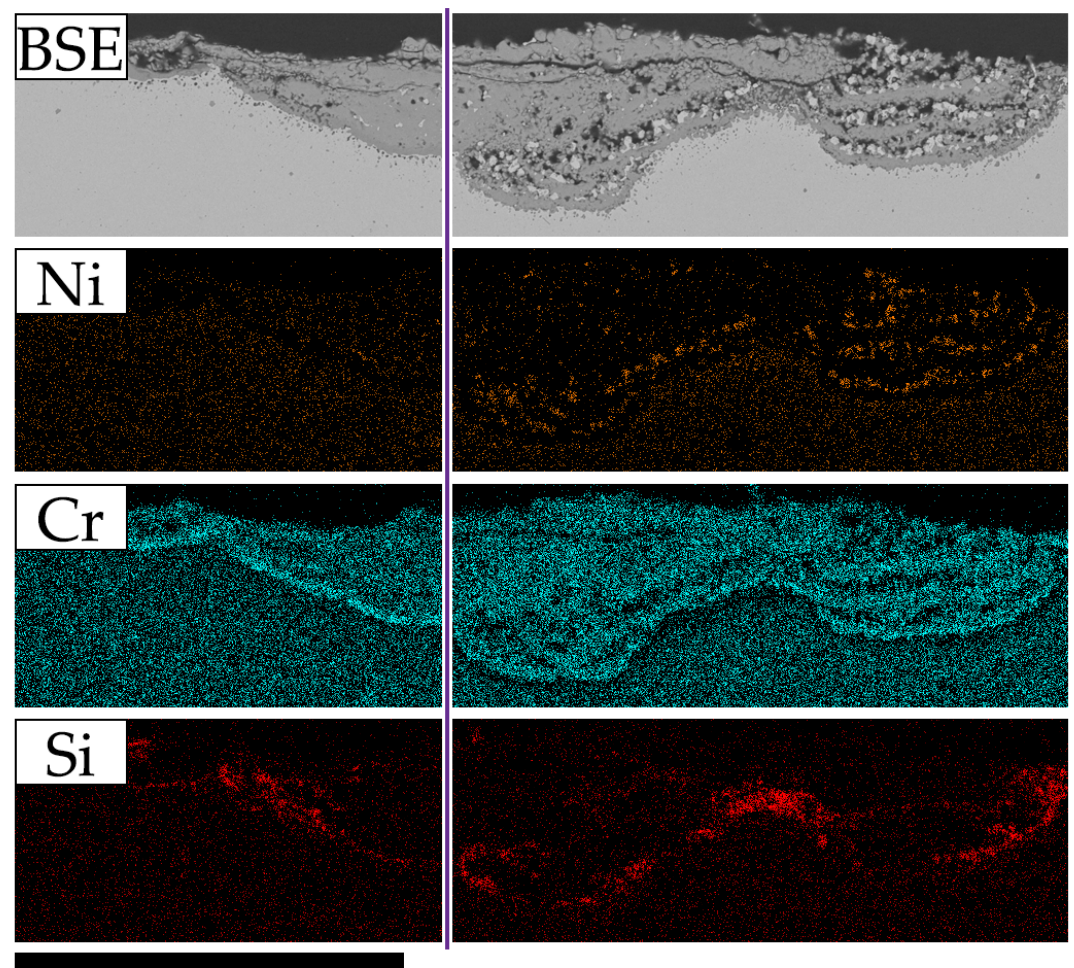
Figure 16. BSE, Ni, Cr and Si EDS maps from the sample 1225 °C in oxyfuel atmosphere. Scale bar is 100 μ m.